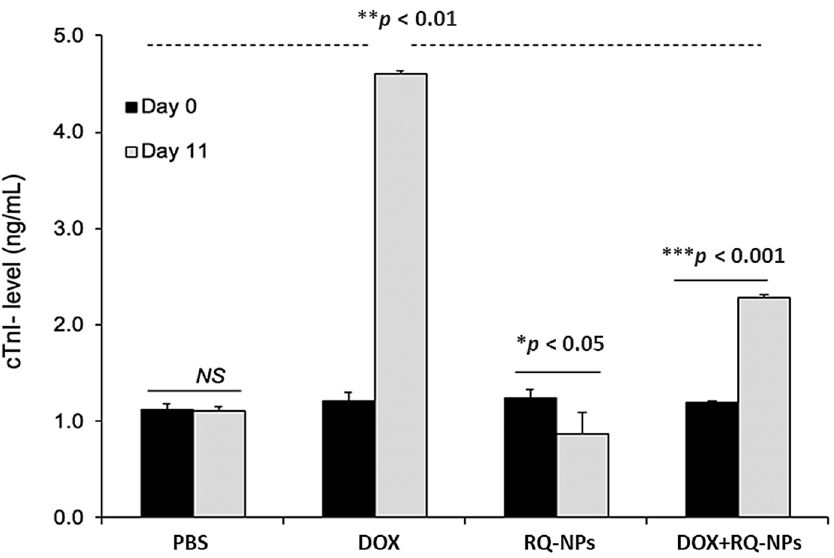
Figure 5. Effect of DOX + RQ-NPs, doxorubicin (DOX), and their combination on plasma troponin I levels (cTn-I). Values are expressed as the mean ± SEM. * p < 0.05, ** p < 0.01, and *** p < 0.001. NS means nonsignificant.